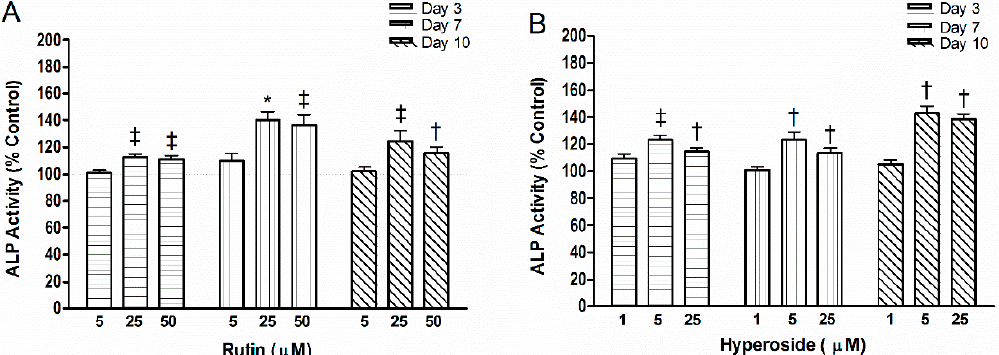
Figure 2. Alkaline phosphatase activity (ALP) activity with addition of ( A ) rutin or ( B ) hyperoside. Activity was measured by the rate of hydrolysis of p-nitrophenyl phosphate. Significant differences are indicated by: † p < 0.05, ‡ p < 0.01, * p < 0.001 compared to control within a day. Each bar represents n = 6.